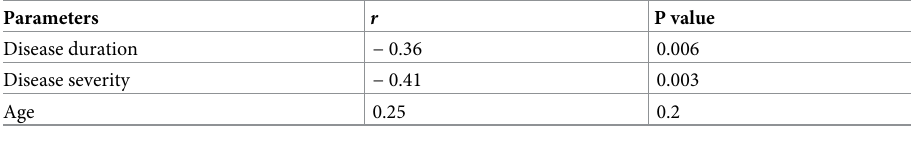
Table 2. Correlation between mtDNA-CN number and clinical variables in psoriasis patients.